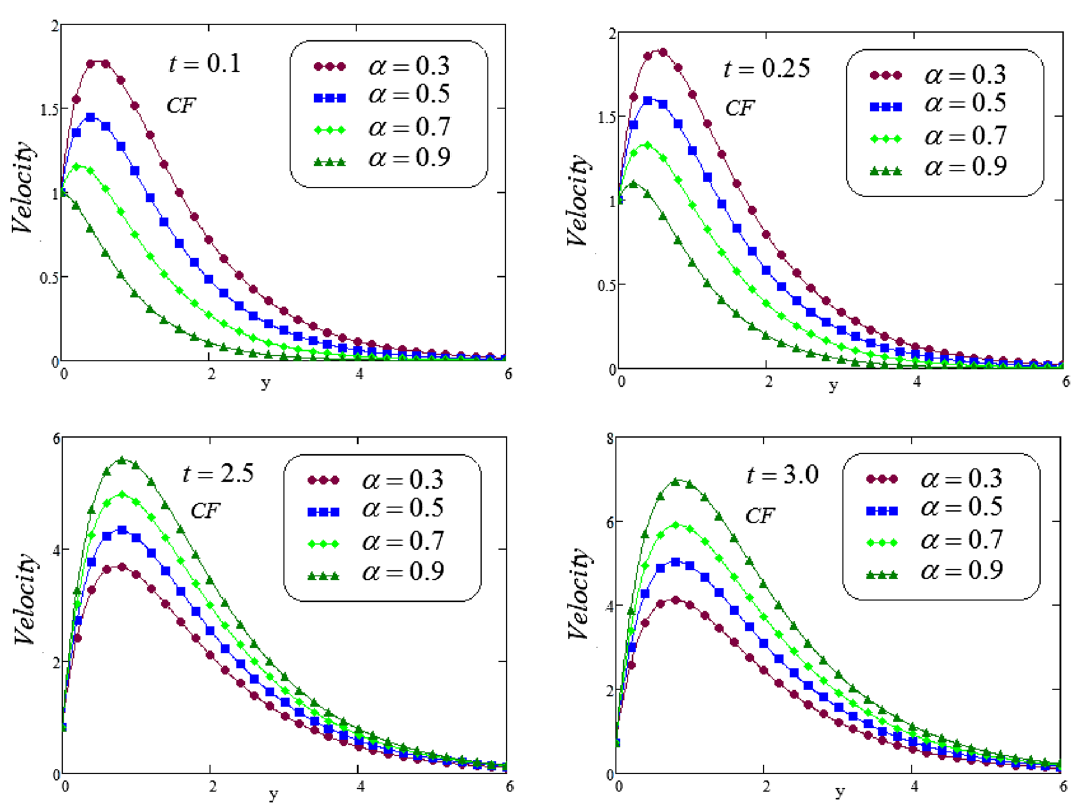
Figure 15. Trace of dimensionless velocity for CF fractional operator for varying the values of α